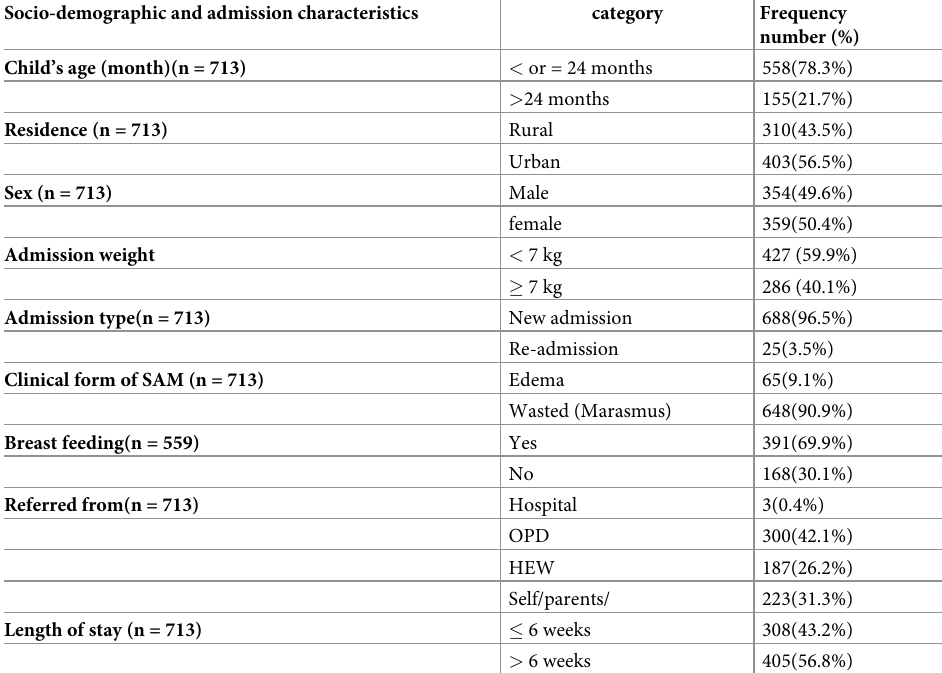
Table 1. Socio- demographic and admission characteristics of children with SAM enrolled to OTP in Dire Dawa, Ethiopia; from January, 2013 to December, 2016. Socio-demographic and admission